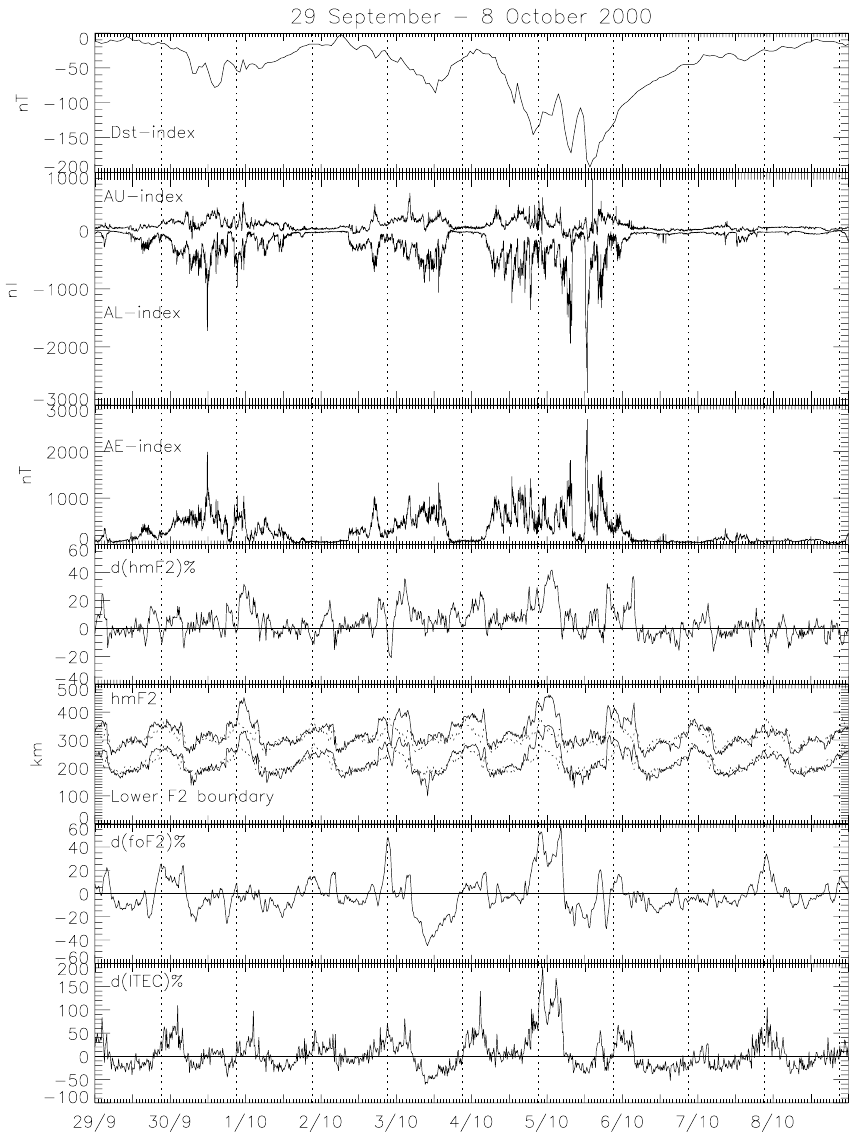
Fig. 1. The overview plot that describes the ionospheric conditions over Athens in response to geomag- netically disturbed conditions recorded from 29 September to 8 October 2000 are presented. The development of the D st index is presented in the first panel, in hourly resolution. In the following two panels, the 1-min values of the AU , AL and AE indices are presented. The vertical dotted lines indicate the local midnight. The variations in the peak height of the F2-layer are presented in the fourth panel of Fig. 1. In terms of the d( hm F2)% deviations from the quiet values, the peak height of the F2- layer, together with the lower F2-layer boundary ( hm F2– B 0), are given in the following panel, and finally, the rela- tive d( fo F2)% deviations with respect to quiet values for this time interval fol- lowed by the d(ITEC)% variations are plotted in the two bottom panels. The solid lines represent the observed pa- rameters, while the dotted lines repre- sent their diurnal quiet time